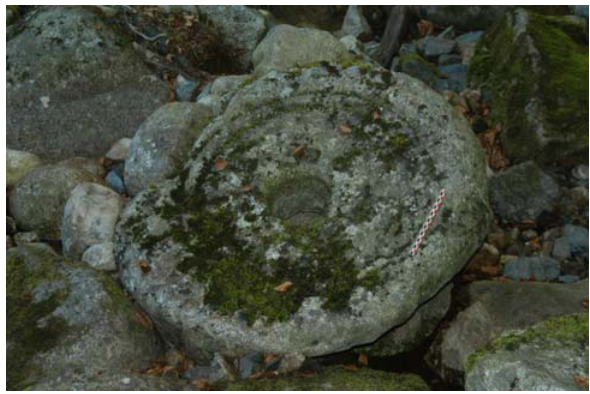
Figure 12. Mill stone on the archaeological site